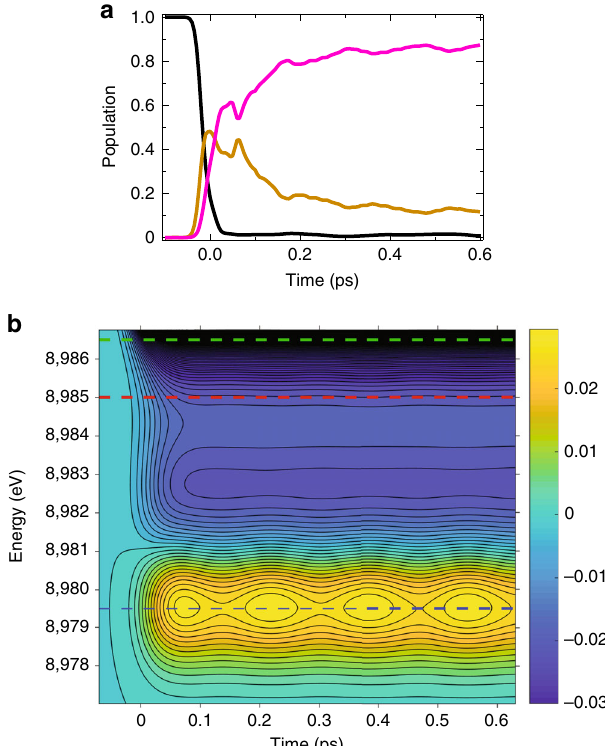
Fig. 4 Quantum dynamics simulations. a Calculated population kinetics of the ground (black), singlet (brown), and triplet (pink) states following the excitation into the S 1 state. b Time-resolved XANES calculated from this dynamics. The blue, red, and green dashed lines correspond to 8979.5, 8985.0, and 8986.5 eV,